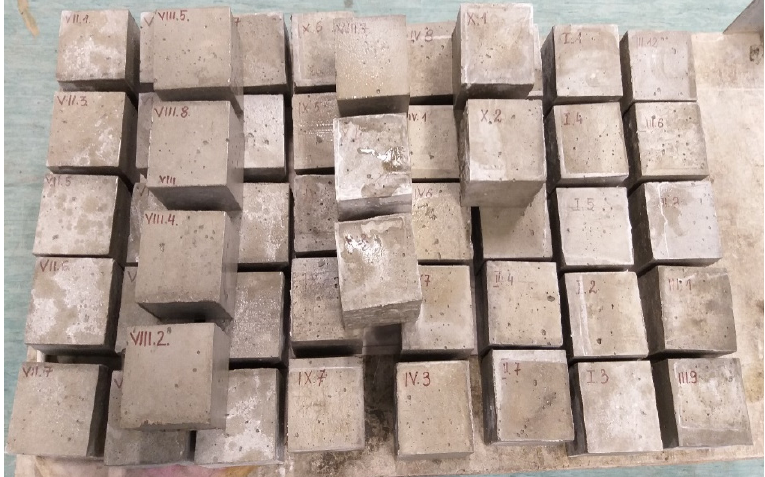
Figure 4. Concrete cubes prepared for testing.